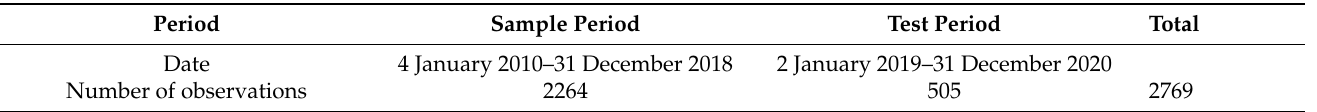
Table 5. Sample and test